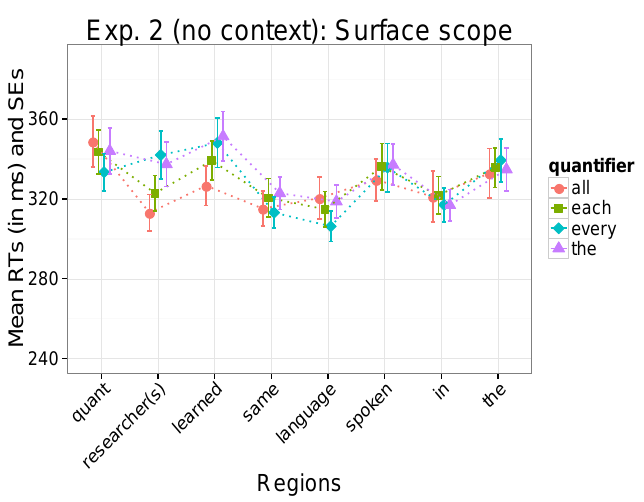
Figure 7 Mean RTs and SEs for all ROIs in Experiment 2 (no context); surface scope only.